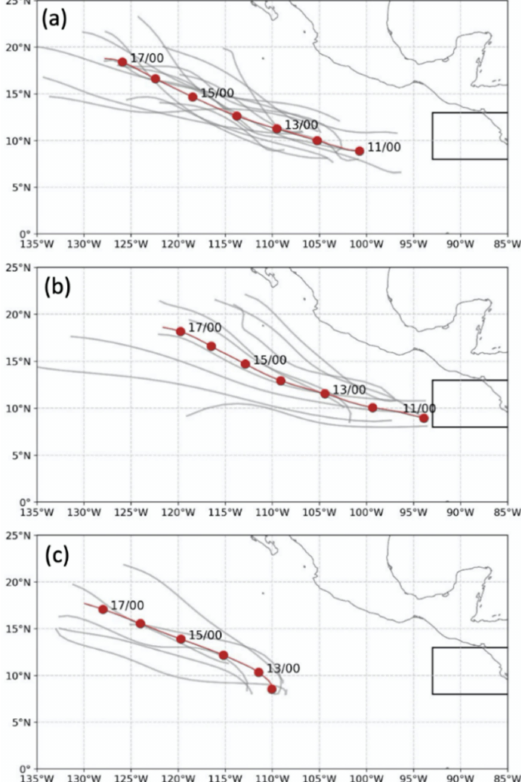
Figure 8. ECEPS 12 UTC 02 July 2021 forecasts of ensemble member tracks (gray lines) and WMVM tracks (red lines) as in Figure 5c in which there are three options ( a ) Storm 9, ( b ) Storm 11, and ( c ) Storm 12 among which a forecaster would need to select the more likely real Tropical Storm Felicia with the potential to become a hurricane (see